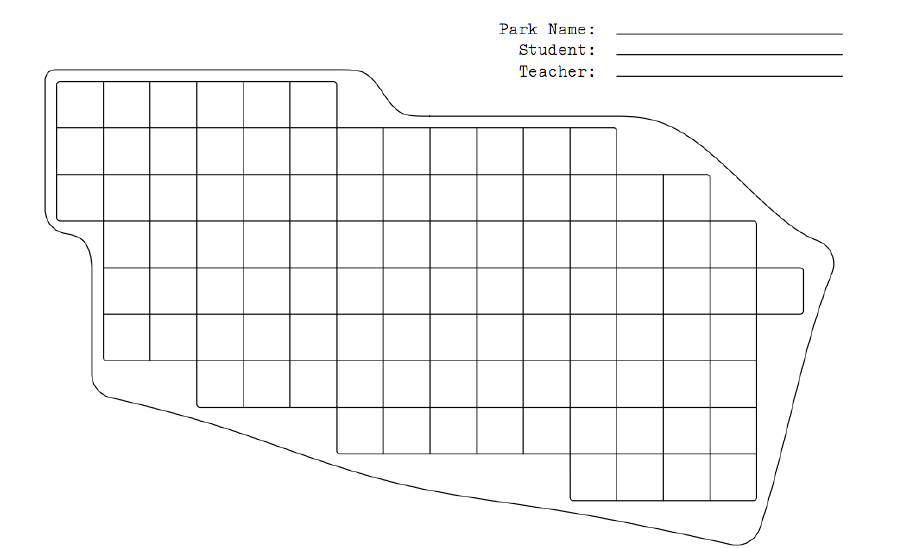
Figure 2: Empty map ready for populating with features